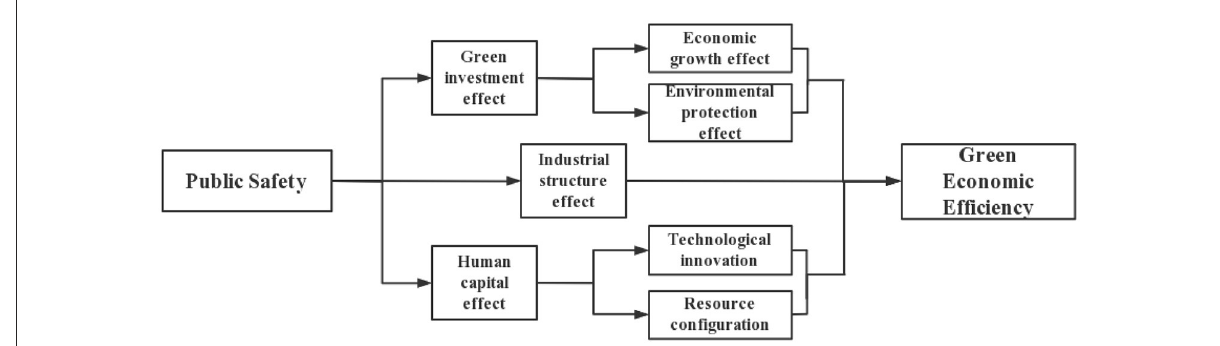
FIGURE1 Association and transmission mechanism of public safety and green economic efficiency.